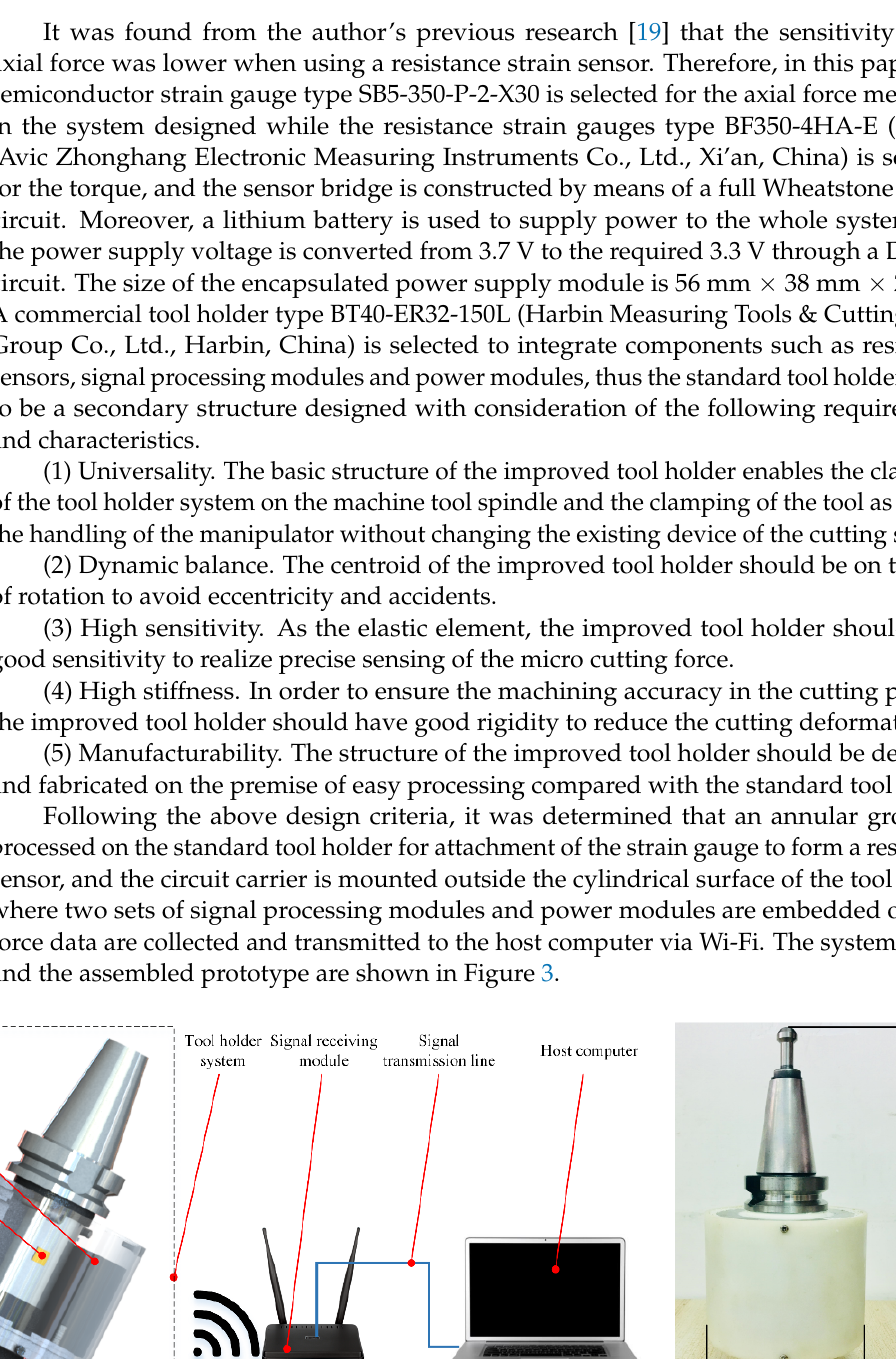
Figure 3. ( a ) intelligent tool holder system composition; ( b ) assembled system.